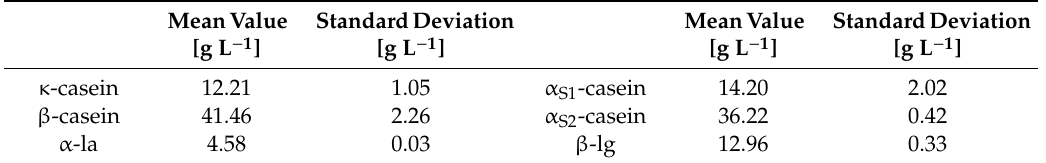
Table 2. Mean composition of the caseins and major whey proteins α -lactalbumin ( α -la) and β -lactoglobulin ( β -lg) of the UF-concentrate CF 3.